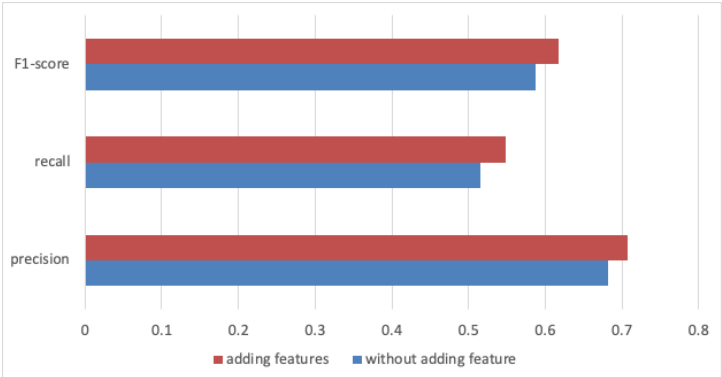
Figure 10. Comparison of before and after adding features (class attribute, method parameter and method return) to the traceability link vector definition.